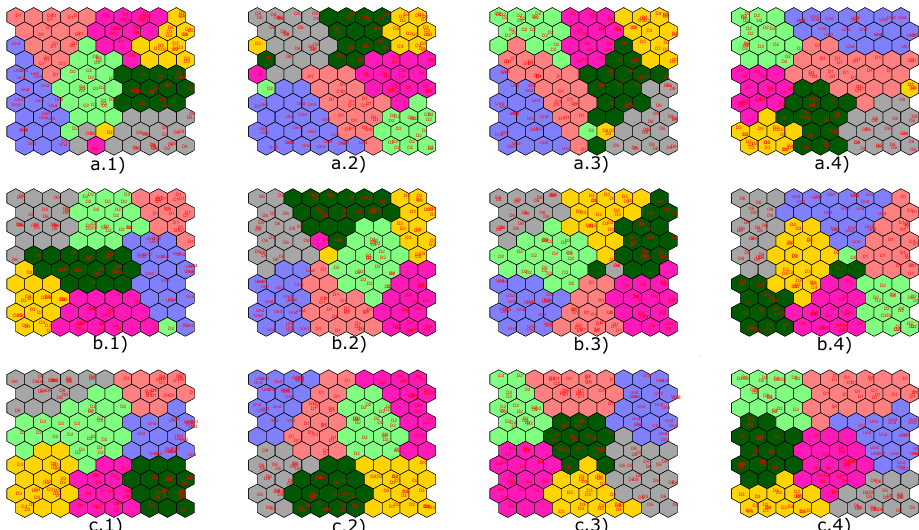
Figure 34. Results obtained by implementing the CPANN ( a ), SKN ( b ) and XYF ( c ) networks for: 2 principal components (group 1), 4 principal components (group 2), 6 principal components (group 3) and 8 principal components (group